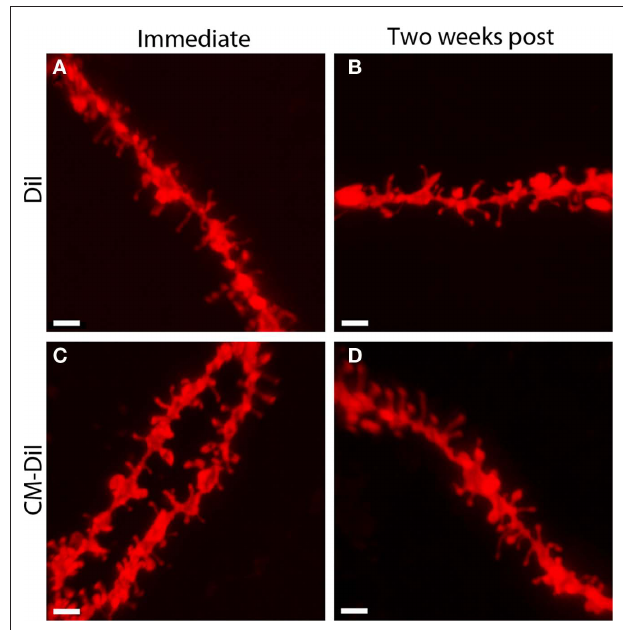
Figure 2 | images of non-permeabilized dendritic segments, labeled with either Dii or CM-Dii. DiI labeled dendritic segment imaged (A) immediately or (B) 2 weeks following tissue mounting. CM-DiI labeled dendritic segment imaged (C) immediately or (D) 2 weeks following tissue mounting. Scale bar is 2